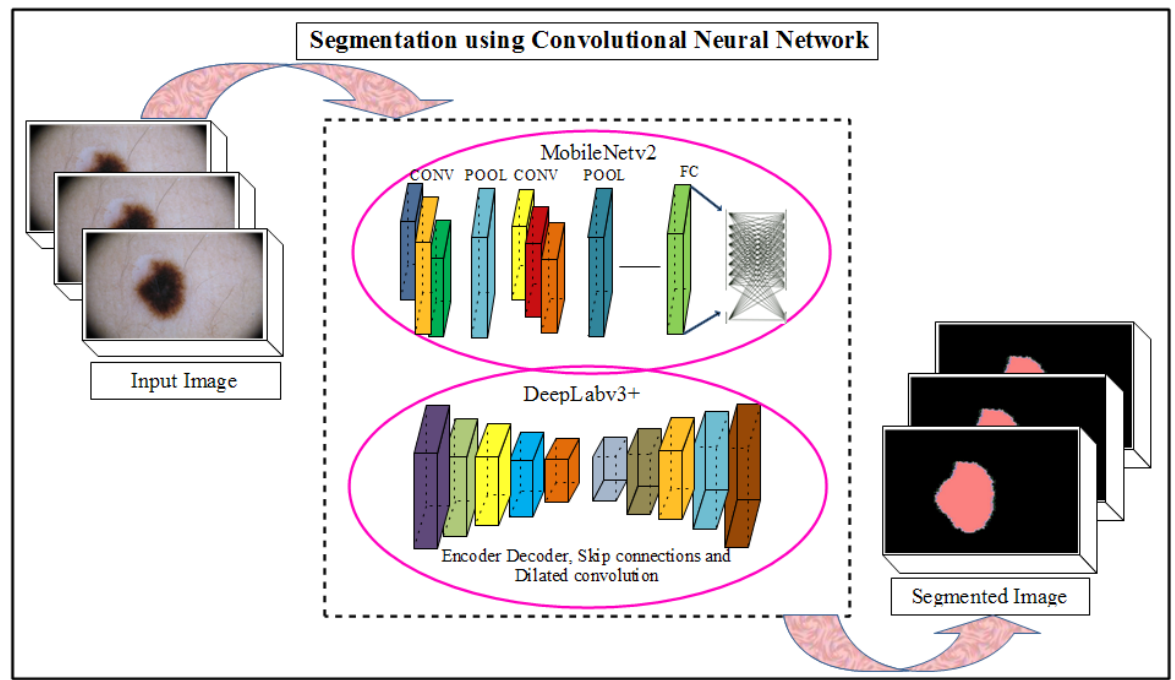
Figure 2. Skin lesions segmentation based on Mobilenet-v2 and Deeplabv3+. The parameters of segmentation are mentioned in Table